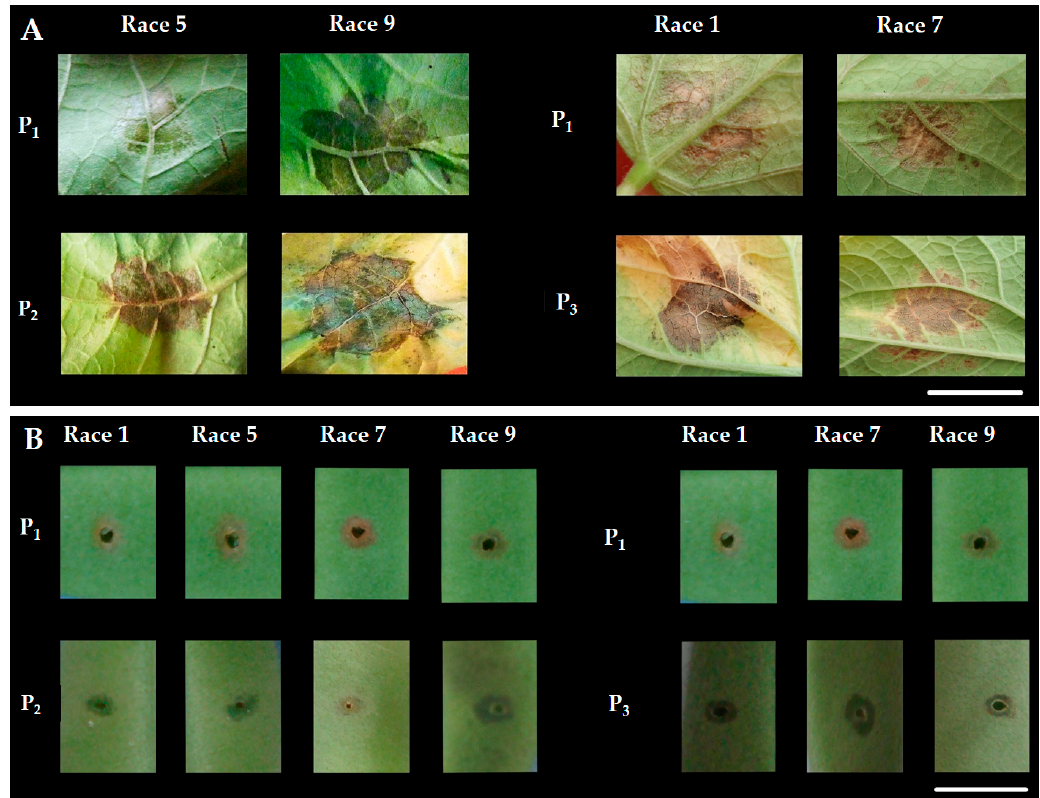
Figure 4. Reaction phenotypes to races 1, 5, 7 and 9 of Psp observed in UI3 (P 1 ), Tendergreen (P 2 ) and A52 (P 3 ) for: primary leaf ( A ) and pod ( B ). Scale of 1 cm.